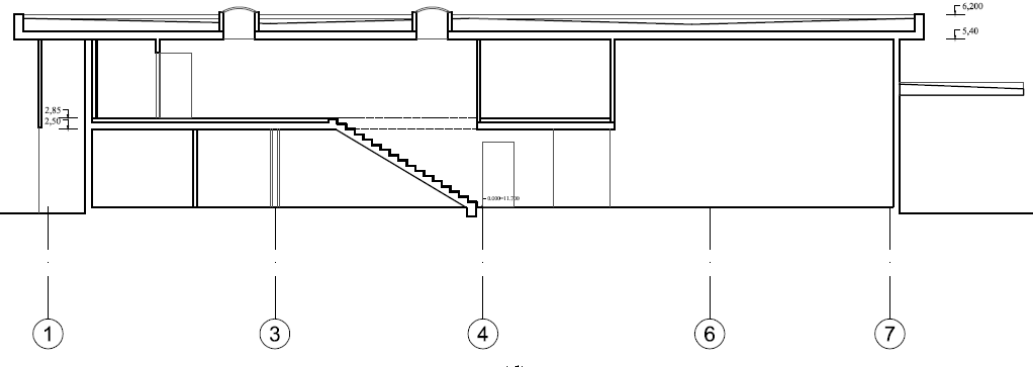
Figure 1. First-floor plan of the analysed building ( a ); second-floor plan ( b ); facade ( c ) and section drawings ( d ). Where: the numbers indicate the coordination axes along the side of the building, while the letters indicate the coordination axes across the side of the building. The extension lines marked with a sign, which is an arrow with a shelf indicate elevation marks of levels (heights) of the building.